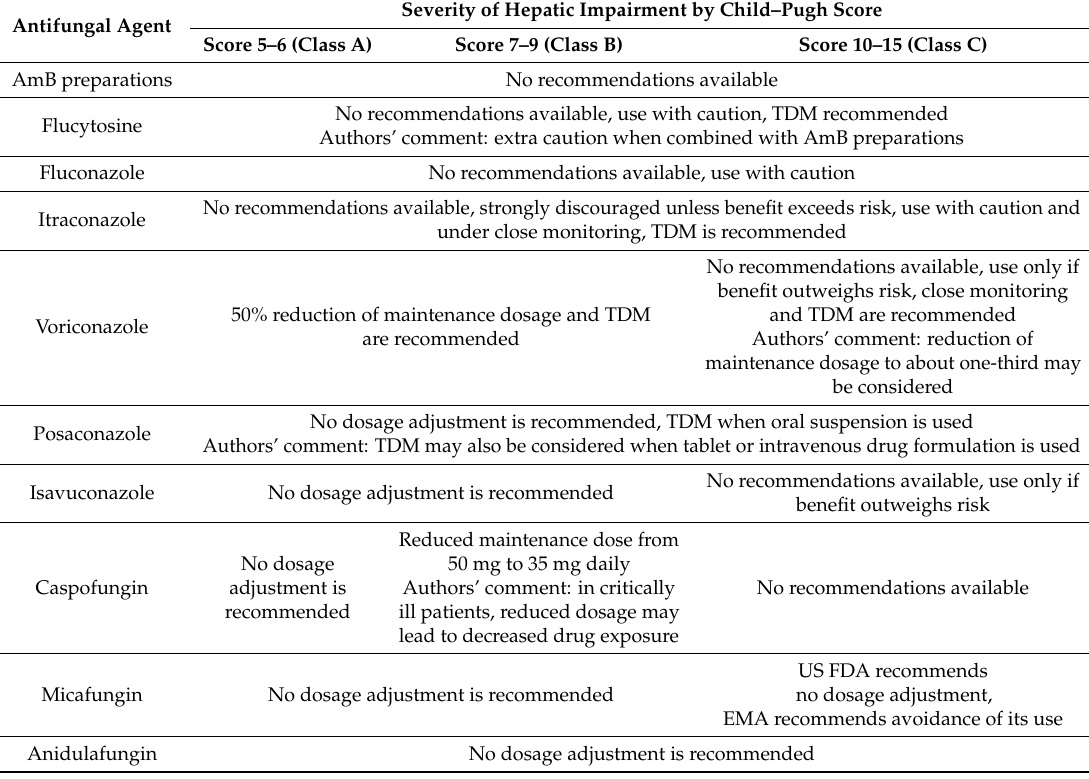
Table 2. Antifungal agent dosage adjustment for patients with hepatic